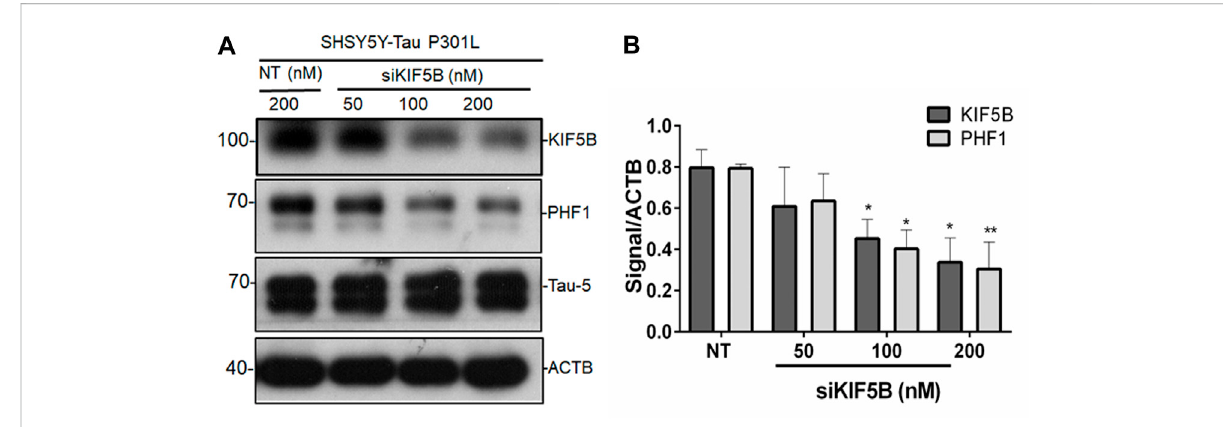
FIGURE 2 KIF5B negatively regulates phospho tau PHF1. (A) The protein level of KIF5B, PHF1 and Tau-5 was measured in western blotting after transfection of SHSY5Y-Tau-P301L cells with KIF5B siRNA or nontargeting (NT) siRNA; ACTB was used as a loading control. (B) Quantitative analysis showed that KIF5B knockdown signi fi cantly increased KIF5B and PHF1 levels without altering Tau-5. The histogram represents the mean ± SEM of 3 independent experiments; * p < 0.05, *** p < 0.01 signi fi cantly different from NT-siRNA control-treated